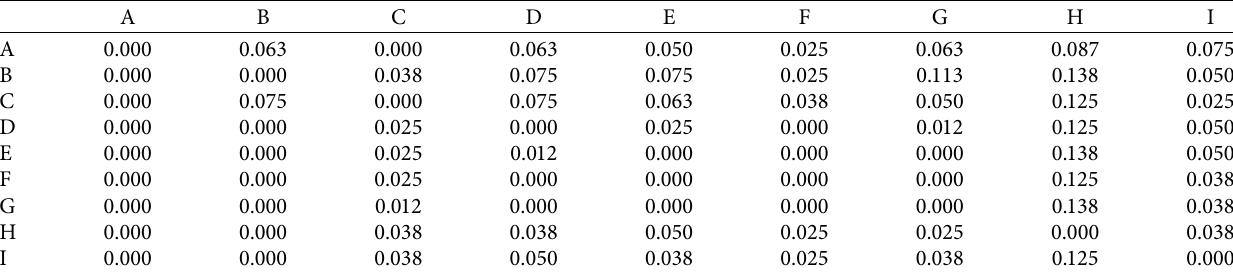
Table 16: The normalized direct relation